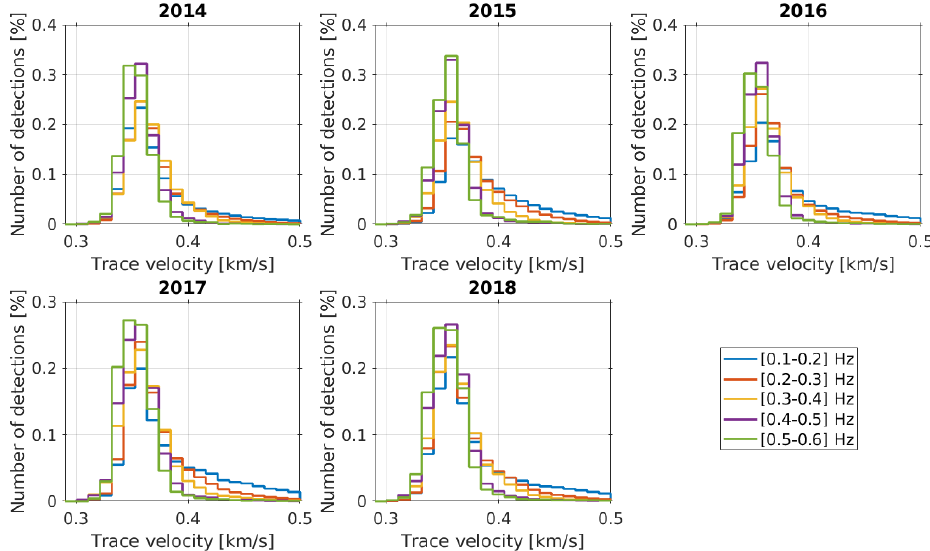
Figure A1. Trace (apparent) velocity values as predicted by the PMCC for the IS37 infrasound station in 2014–2018. Frequency bands are color-coded as follows: blue – 0.1–0.2Hz; orange – 0.2–0.3Hz; yellow – 0.3–0.4Hz; purple – 0.4–0.5Hz; green –